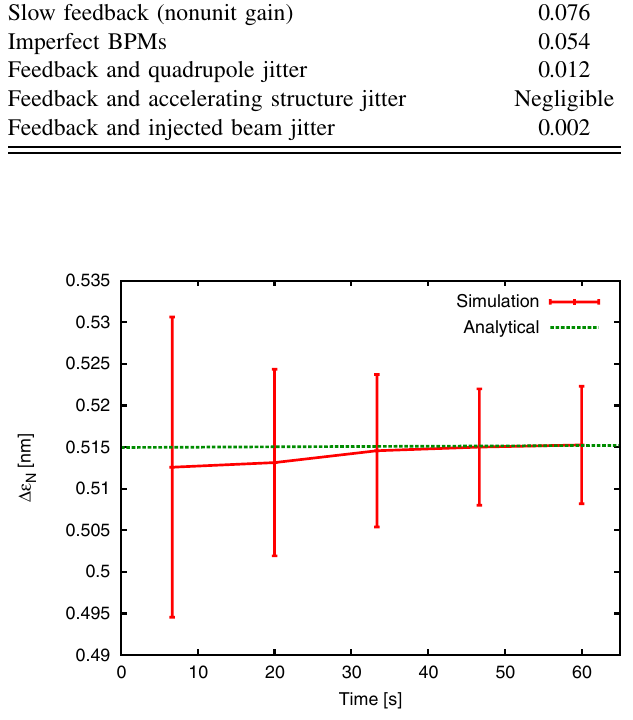
FIG. 26. (Color) Multipulse emittance growth caused by imper- fections according to Table II. The result of simulations was obtained as an average of 50 random seeds and agrees very well with analytical predictions.